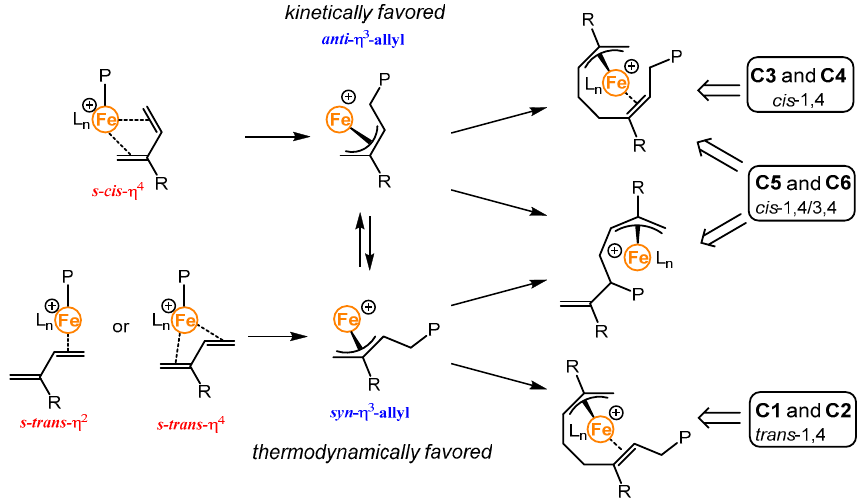
Figure 7. Structure-properties relationships in iminopyridyl iron-based catalysts issued from ( a ) ketiminopyridyl C1 – C2 , ( b ) aldiminopyridyl C3-C4 and ( c ) fluoroaryl-ketiminopyridyl C5-C6